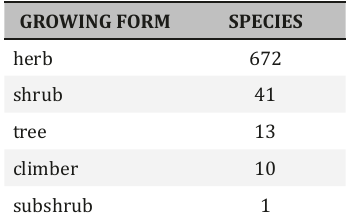
Growing form and number of species of alien flora in Chile. GROWING FORM